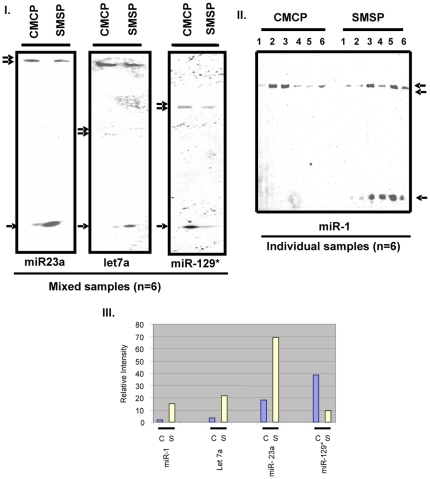
Analyses of mature microRNAs of interest found in both micro-array and RT-PCR analysis.Denaturing Urea-Acrylamide gel electrophoresis of total RNA (10 µg) have been run and subjected to Northern Blot analysis using P32-labelled LNA-based microRNA probes (Exiqon) either as mixed samples of 6 SKM RNA (I) or separately for 6 samples for miR-1 (II). The single arrow stands for the mature microRNA of appropriate size and the double arrow signifies the precursor forms, 60–100 bases. SMSP is the experimental against CMCP as control animal samples. III. Relative intensities of the bands in I and II.